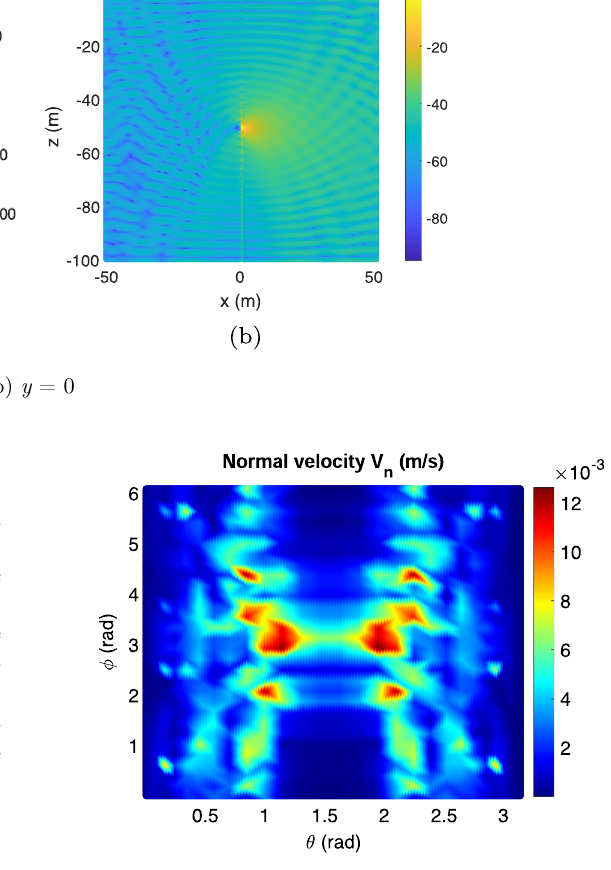
Figure 14. Normal velocity v n on the actual source o D a